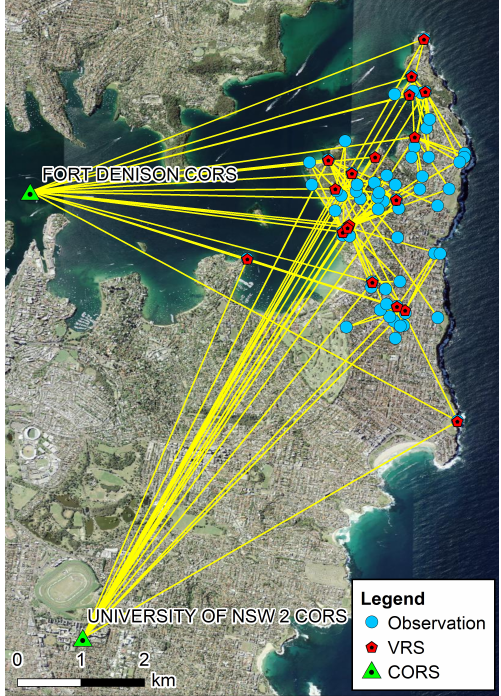
Fig. 7. NRTK baseline network including the joins from each VRS to the two nearest CORS.